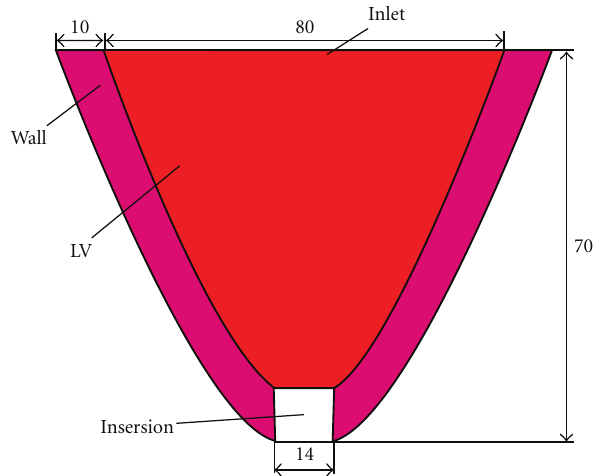
Figure 2: LV geometry model used to compare the inflow cannula